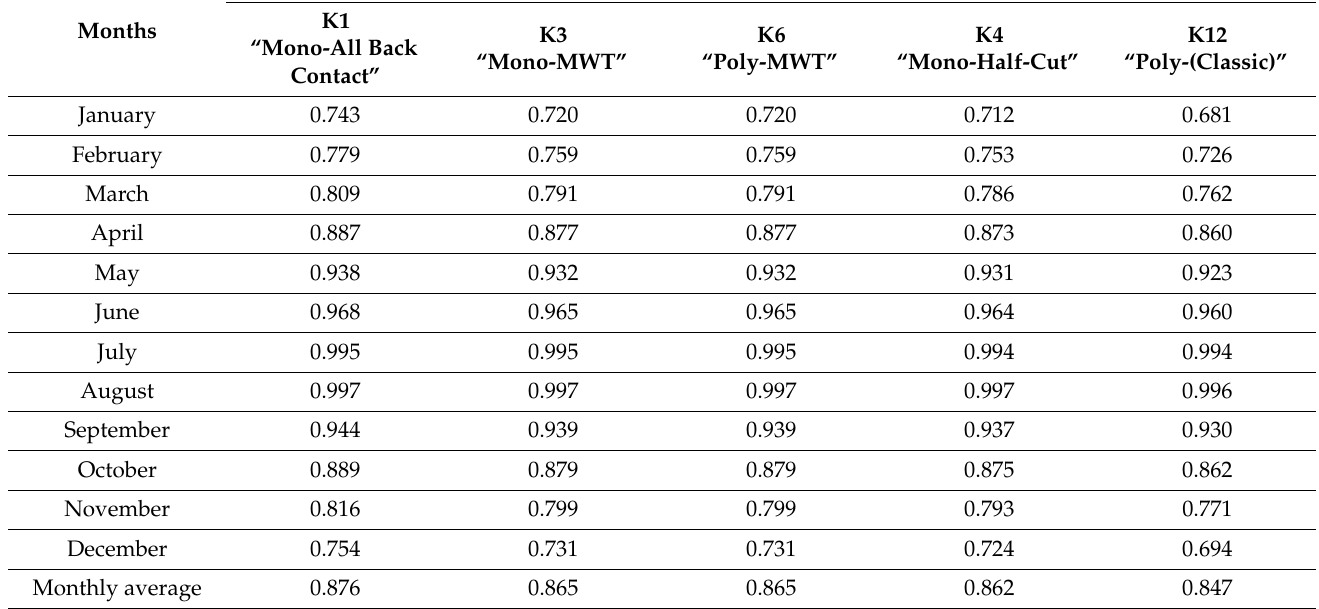
Table 9. Adjustment factors for the amount of energy generated by photovoltaic panels depending on changes in ambient